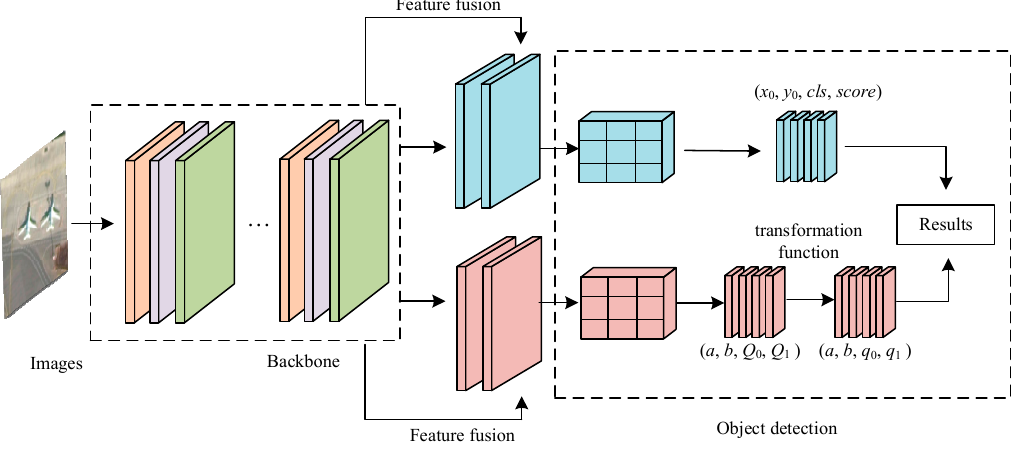
Figure 3. A schematic diagram of network structure.